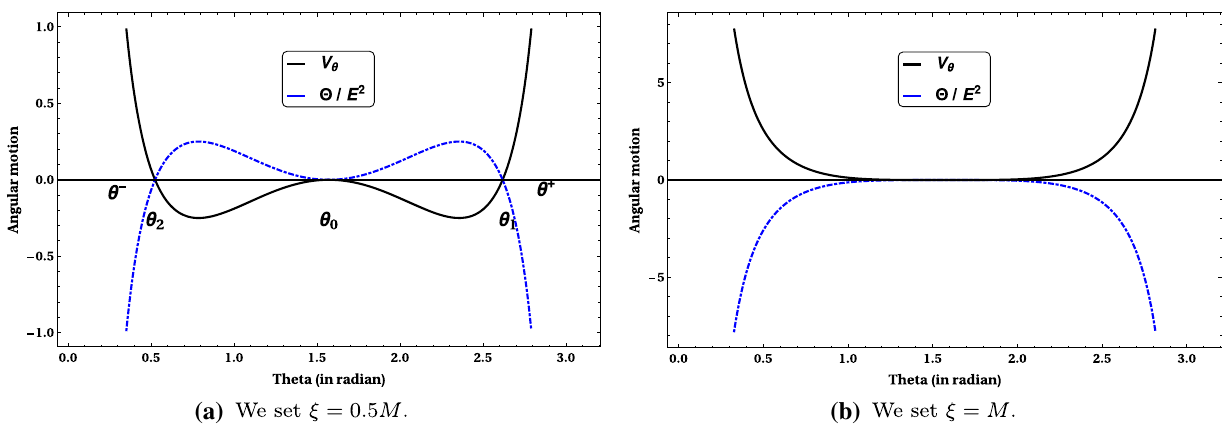
Fig. 5 Angular potential and momentum for vanishing Carter constant (i.e., λ = 0) has been presented for the following choice of the black hole rotation parameter: a =